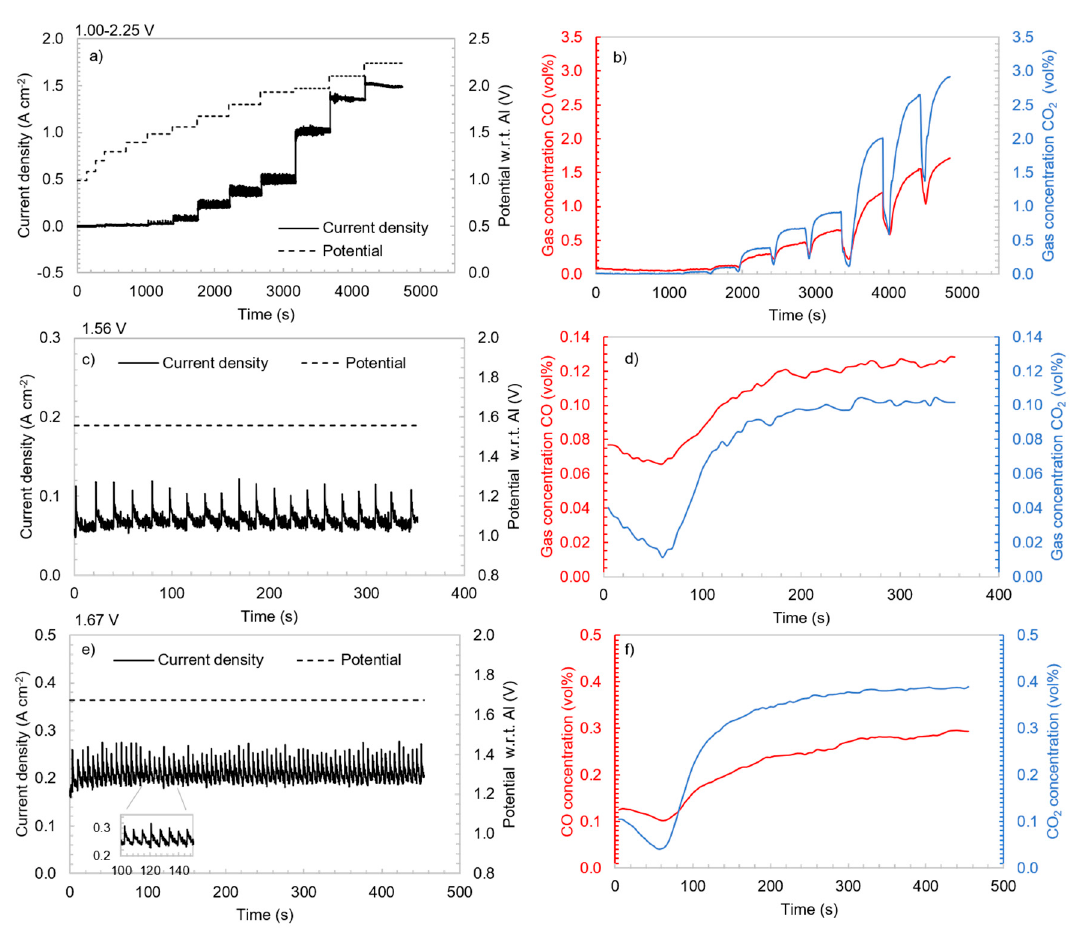
Figure 9. ( a ) Current response and ( b ) CO-CO 2 concentration for the rod anode at potential-controlled electrolysis in the potential range 1.00–2.25 V, ( c ) Current response and ( d ) CO-CO 2 concentration for the rod anode at constant potential of 1.56 V, ( e ) Current response and ( f ) CO-CO 2 concentration for the rod anode at constant potential of 1.67 V.